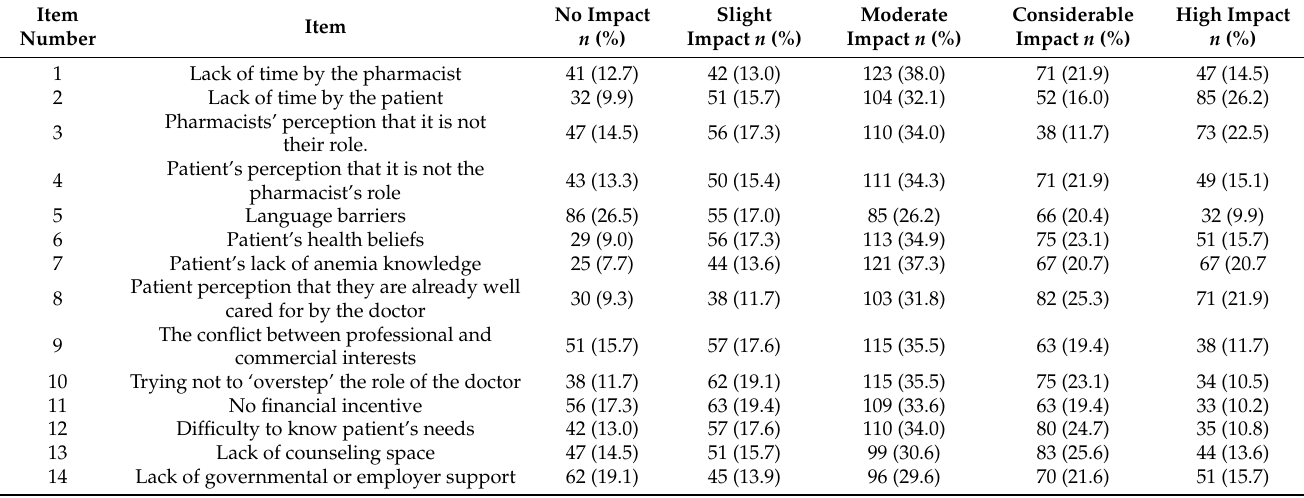
Table 5. Perceived practice barriers to pharmacist’s ability to provide specific anemia counseling or